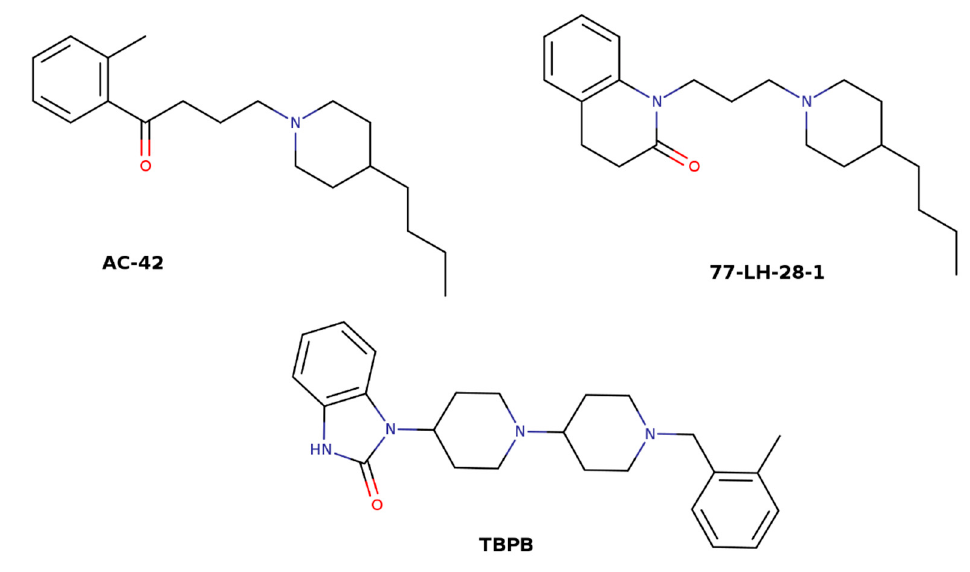
Figure 6. Structures of bitopic ligands AC-42, 77-LH-28-1, and TBPB.